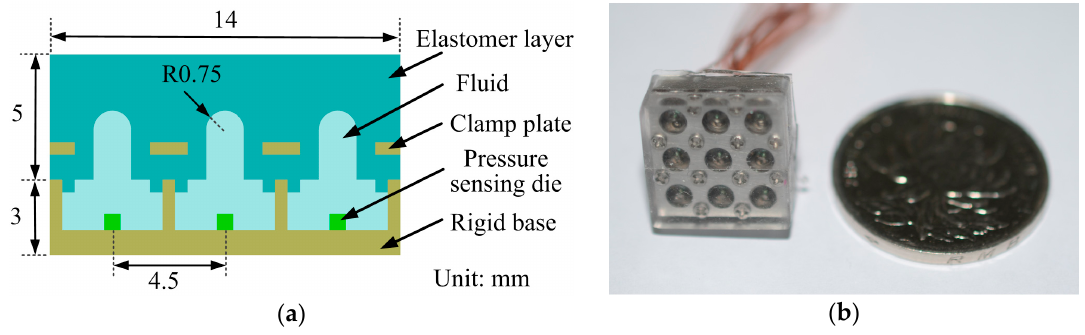
Figure 6. The sparse tactile sensor array with elastomer layer: ( a ) cross-section view of the sensor array; and ( b ) prototype of the sensor